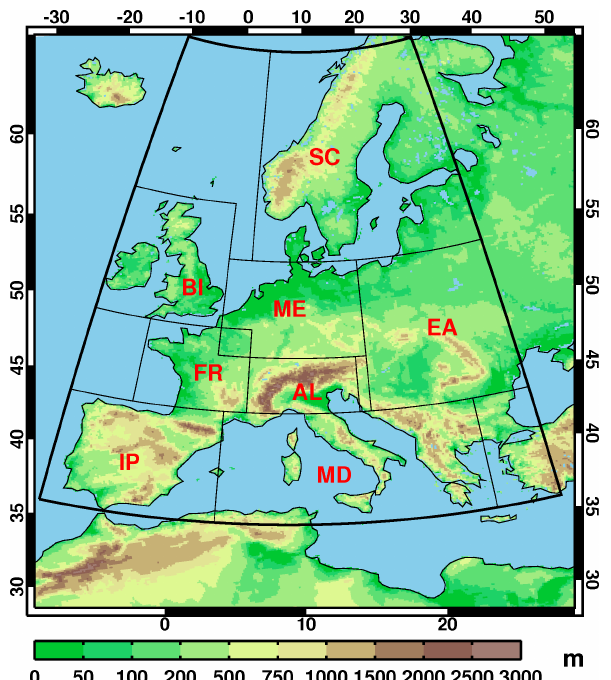
Figure 1. Map showing the eight subdomains (BI – the British Isles; IP – the Iberian Peninsula; FR – France; ME – mid-Europe; SC – Scandinavia; MD – the Mediterranean region; AL – the Alps; EA – eastern Europe) and the larger European domain for which average climate change signals have been calculated. The colours represent the altitude of the surface in the RCA4 model at the 0.11 ◦ EURO-CORDEX